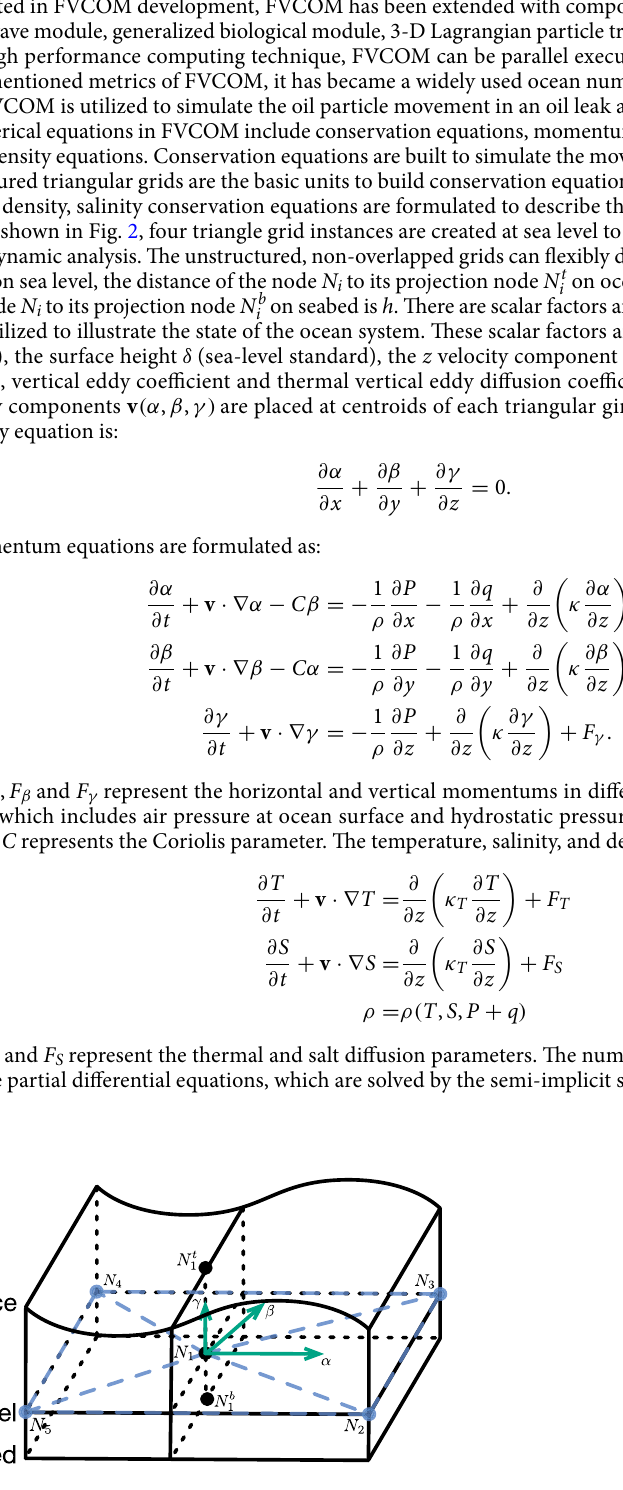
Figure 2. Illustration of a grid instance. N i represents the node i , N on sea surface and